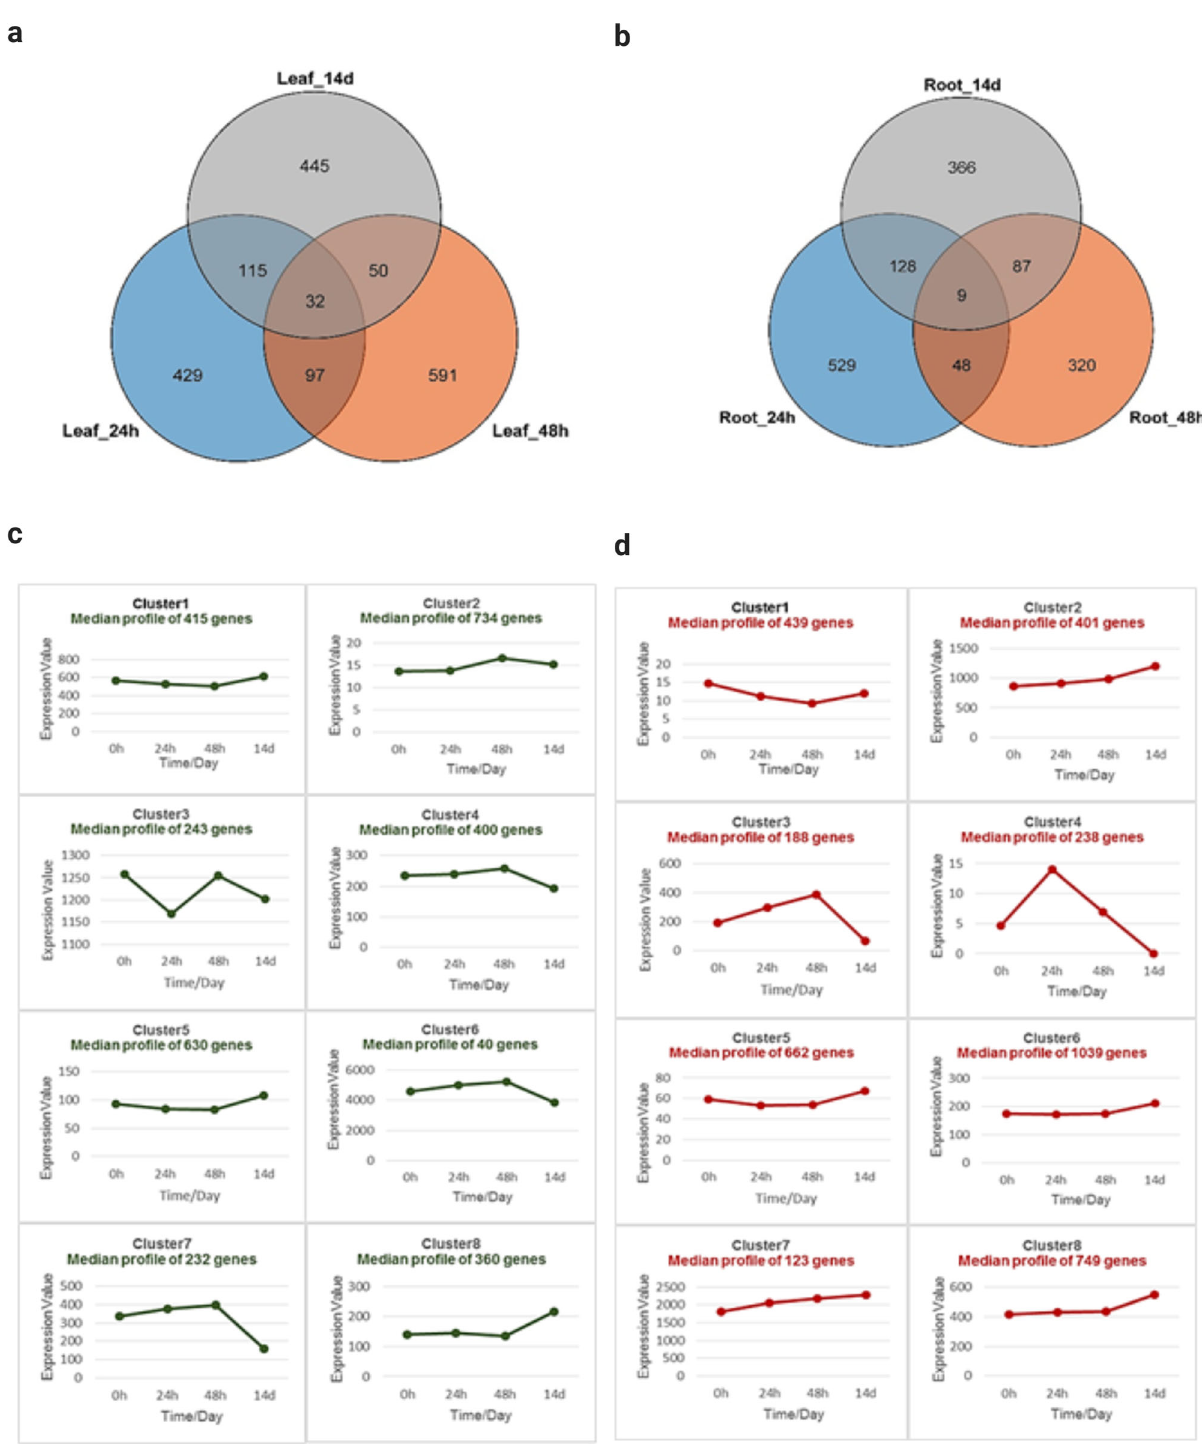
Fig. 4 Salinity-responsive genes from A. marina . Leaf and root tissues were collected from control (Hoagland ’ s solution) and salt-treated (Hoagland ’ s solution supplemented with NaCl) seedlings and salinity-responsive genes were identi fi ed by RNA-Seq analysis. a , b Venn diagram of the differentially expressed genes (DEGs) from A. marina leaves and roots in response to short-term (24, 48 h) and long-term (14d) salinity stress that were analyzed in control-treatment pairs. c , d Time-course analysis and clustering of the DEGs based on their pattern of expression in leaves and roots,